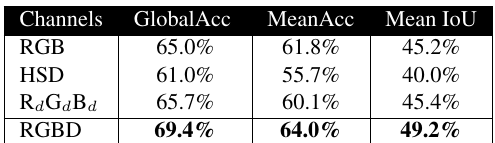
Table 4. Results on semantic labeling of structural elements of buildings in test T1 (50% of the dataset for training and 50% for testing).